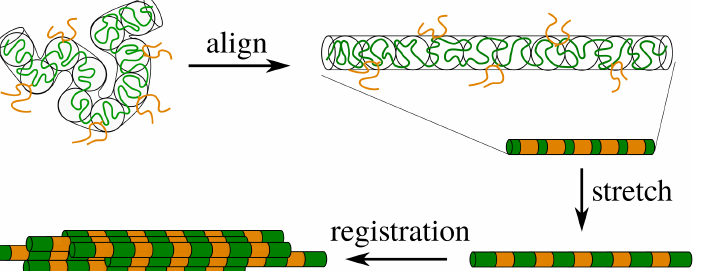
Figure 1. Schematic representation of silk processing. The polymer is entangled and contains stickers (orange) that are connected by linker chains (green). For flow rates that exceed the relaxation rate by reptation, the entanglement blobs of the polymer align in the direction of the flow field. If the chains remain unstretched, the stickers are mobile and the sticker concentration inside the tube is almost homogeneous. Upon modest stretching of the polymer, the distance between the stickers increases and the sticker concentration becomes inhomogeneous, which gives rise to ‘registration points’ that enable the correlation of nearby